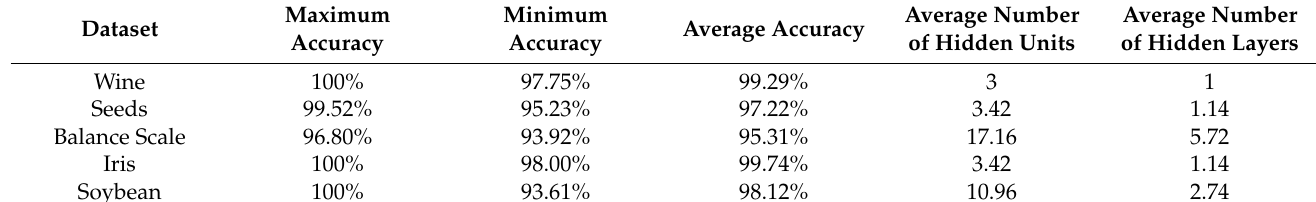
Table 5. The simulation results of the CCNN-MOEA-T algorithm.